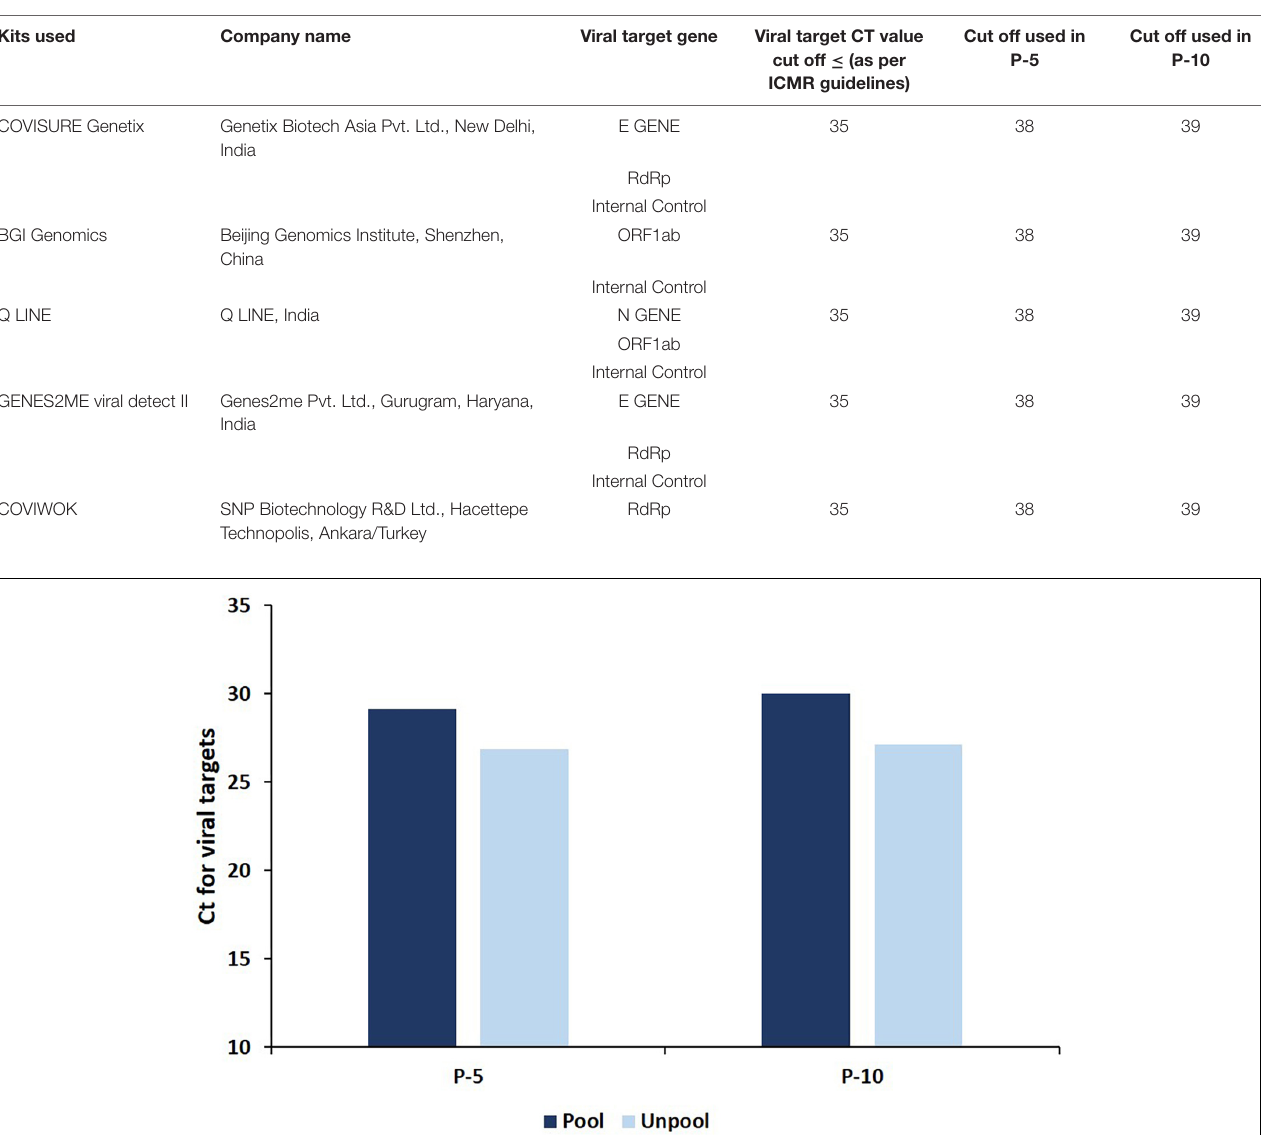
FIGURE 1 | The average Ct for viral targets in deconvoluted (unpool) samples and in pools (P-5 and P-10 strategy) which resulted in only one positive specimen in deconvolution.